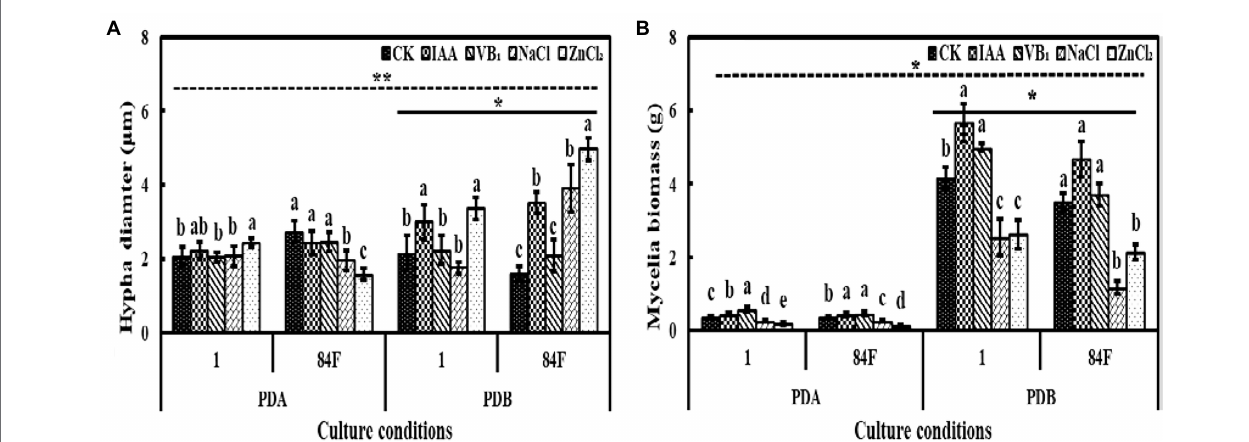
FIGURE 1 | Hyphal diameter and mycelial biomass of Epichloë sinensis under different treatments for 4 weeks. (A) is hyphal diameter, and (B) is mycelial biomass. Different lowercase letters in the figure indicate significant differences between different exogenous additives ( p < 0.05); *on the real line in the figure indicates significant differences between different strains under same culture conditions ( p < 0.05); *on the dotted line in the figure indicates significant differences between different cultures ( p < 0.05).